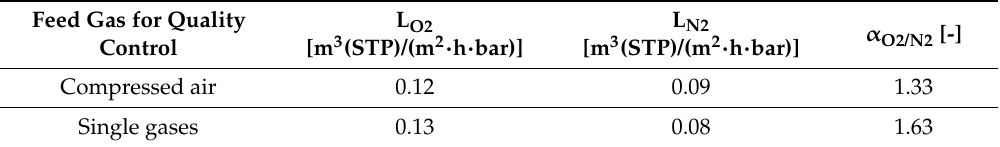
Table 5. Results of SILM module quality control with compressed air and single gases ( ϑ = 25 ◦ C, ∆ p = 2